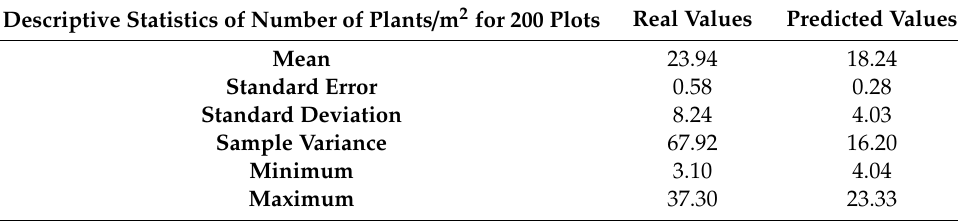
Table 6. Descriptive statistics for 200 plots for the real and predicted number of plants/m 2 . Descriptive Statistics of Number of Plants / m 2 for 200